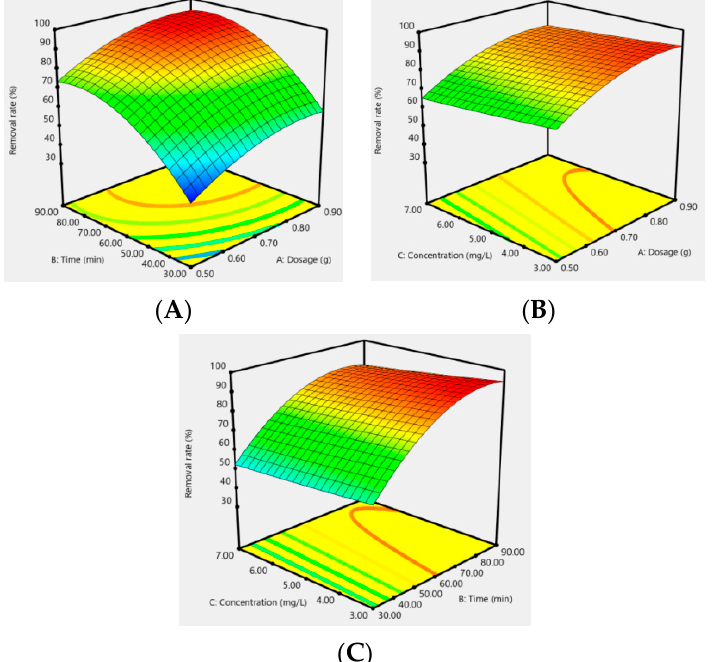
Figure 13. Response surface of the dosage ( A ), contact time ( B ), and concentration ( C ) of AC-ZnO on the removal effect of methylene